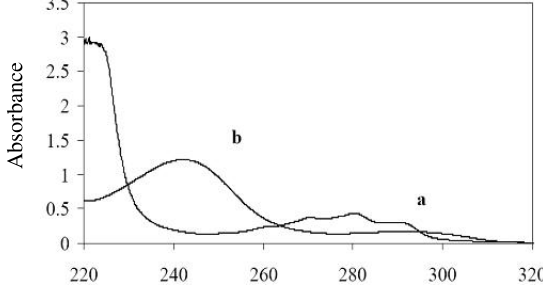
Figure 1. Absorption spectra of (a) naphazoline and (b) antazoline in Britton Robinson buffer at pH 7.0